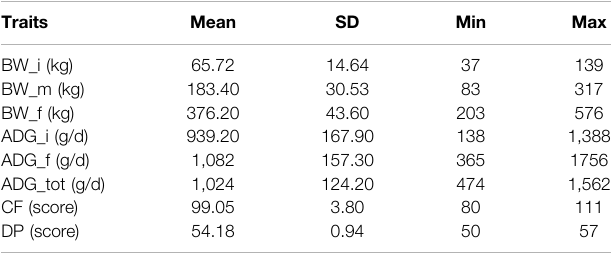
TABLE 1 | Summary statistics for phenotypic data of animals with both genotypic and phenotypic information ( n (cid:2) 689).